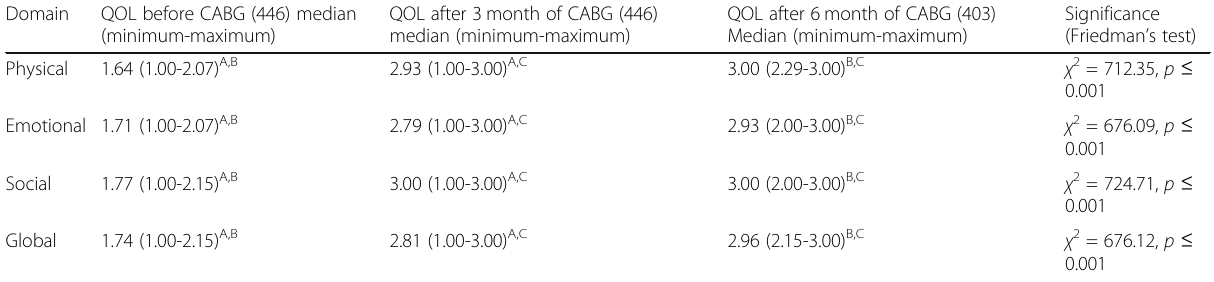
Table 1 Comparison of scores of domains of quality of life before and after CABG